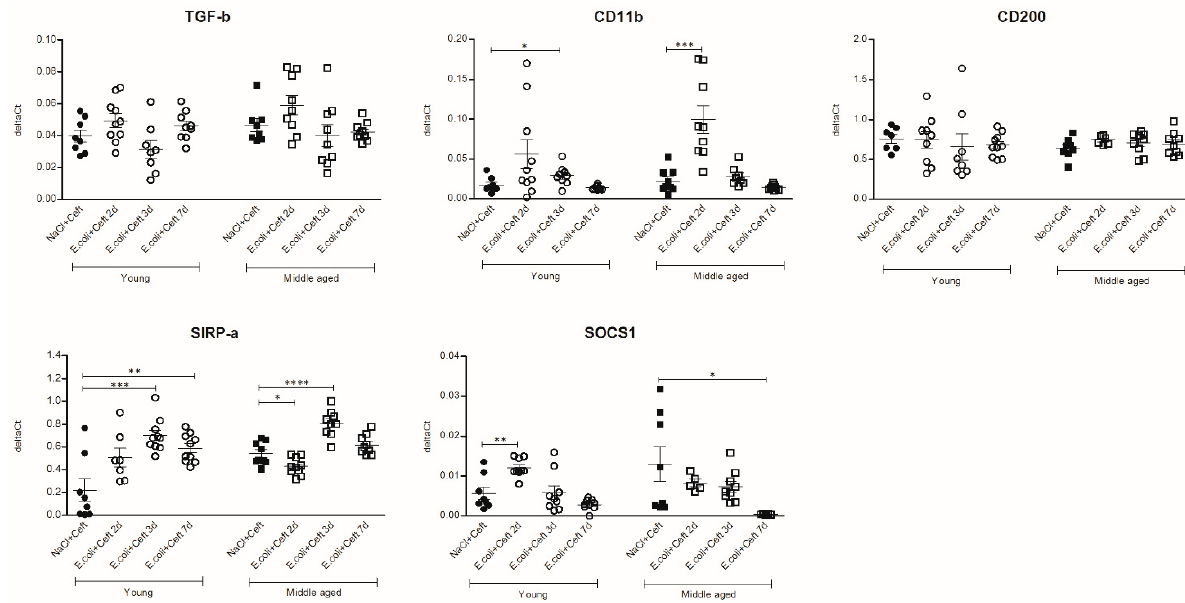
Figure A5. mRNA expression of brain homogenate of TGF- β , CD11b, CD200, SIRP- α and SOCS1 illustrated in deltaCts. Group size varies from n = 8 to 10. Parametric or non-parametric two-way ANOVA (factors: age and time point) was conducted and continuous variables were tested with post-hoc Mann–Whitney U tests or Student t -tests, depending on the distribution of the data. For non-parametric ANOVAs, ranked transformation of the data was performed. Data represent the mean ± SEM, * p ≤ 0.05, ** p ≤ 0.01, *** p ≤ 0.001, **** p ≤ 0.0001.